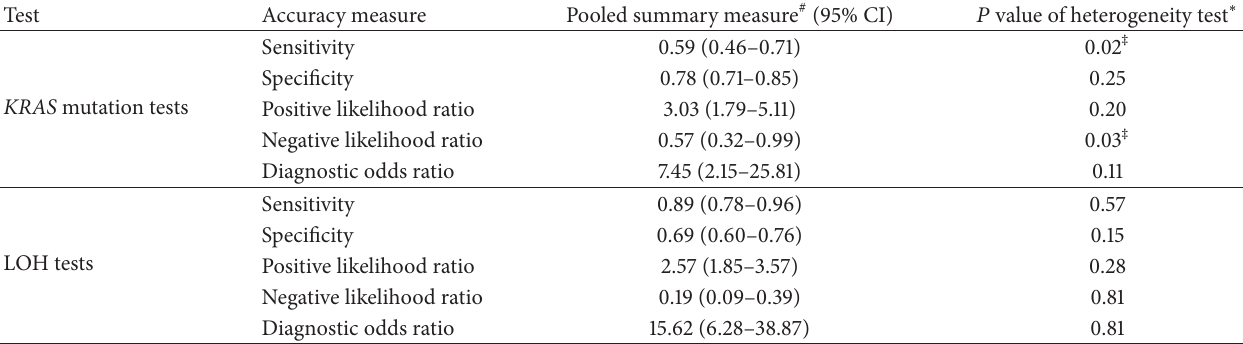
Table 4: Accuracy measures of molecular diagnostic analyses for the differentiation of malignant from benign pancreatic